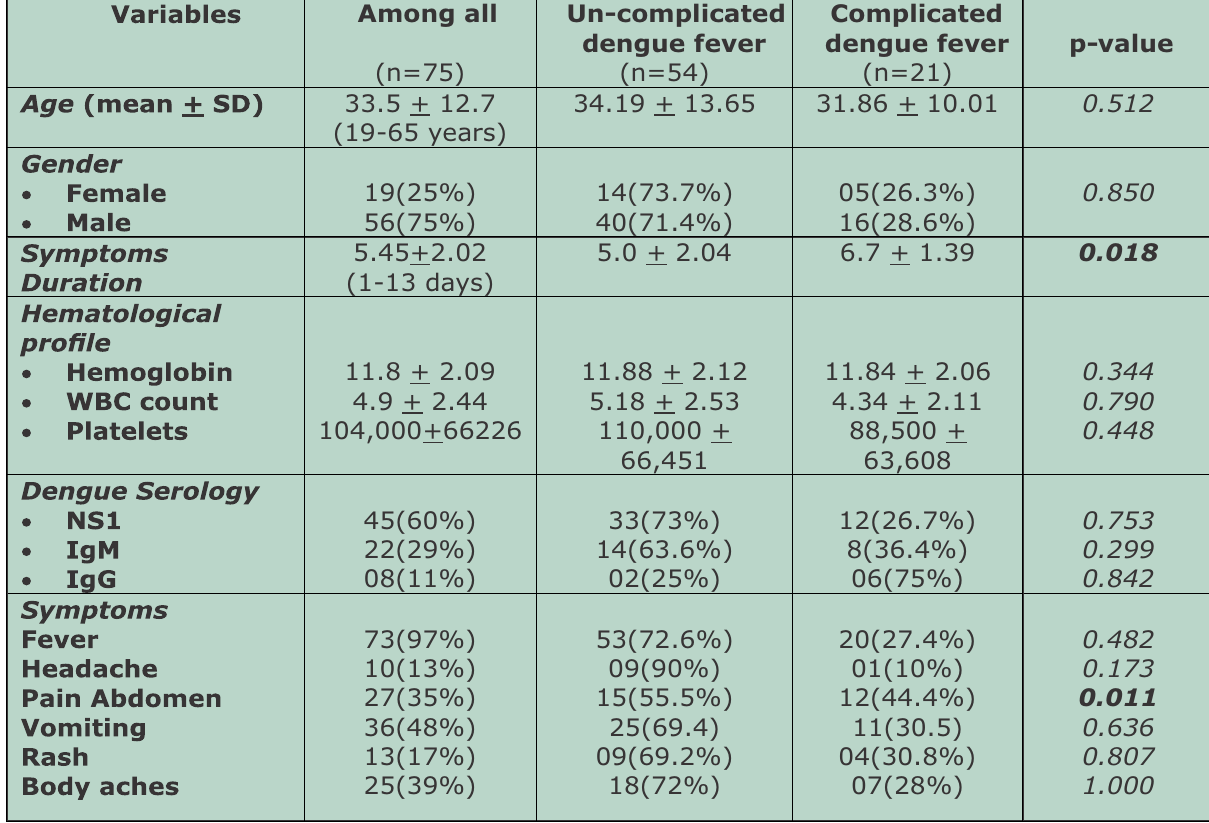
Table-I: The demographic, hematologic, serological variables, and symptomatology of dengue fever cases